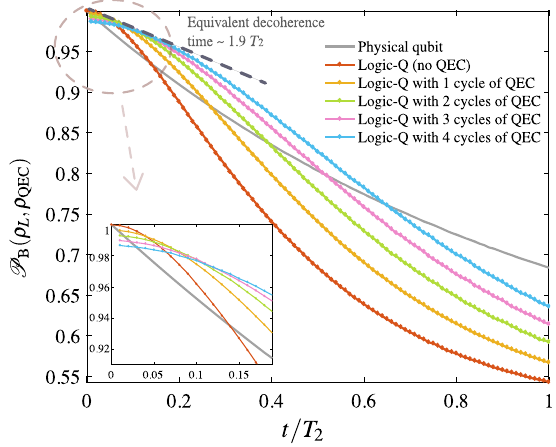
FIG. 32. Multiple cycles of future hardware: Success proba- bility P with QEC according to the shuttling-based, two-species B protocol. The parameters underlying the simulation correspond to the future improved values from Tables II – V. The QEC method used here is the non-fault-tolerant one (cf. Fig. 19), as it takes the shortest possible time and thus has more potential if more error- correction cycles are to be applied within one round. Results show that the application of more QEC cycles sustains the logical qubit for a longer time, as depicted by the grey dashed line, which is drawn based on the envelope of the different curves. As discussed in the main text, the dashed line allows us to infer the effective rate of decay of integrity of the logical